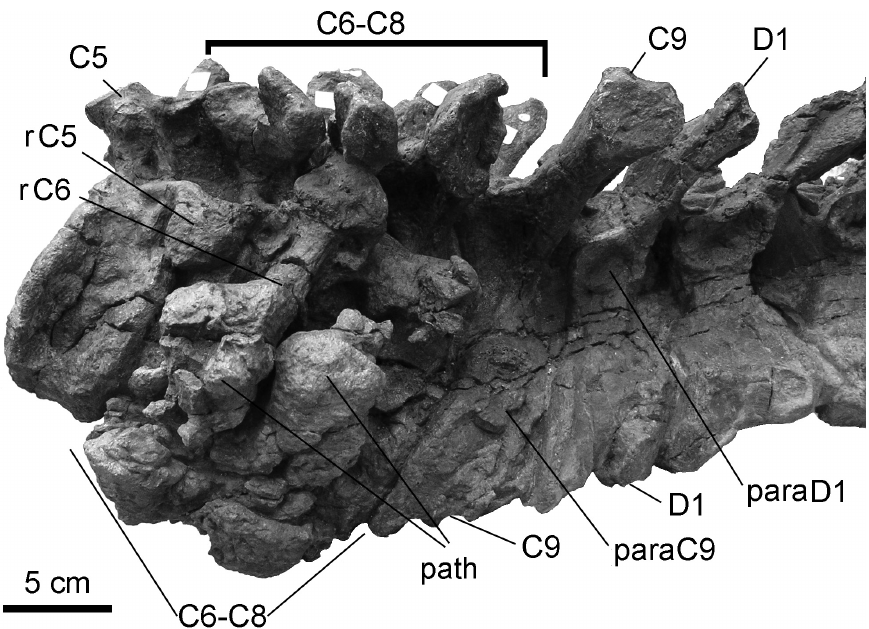
Figure 5. Left aspect of cervical vertebrae showing abnormalities. Vagaceratops irvinensis , CMN 41357.